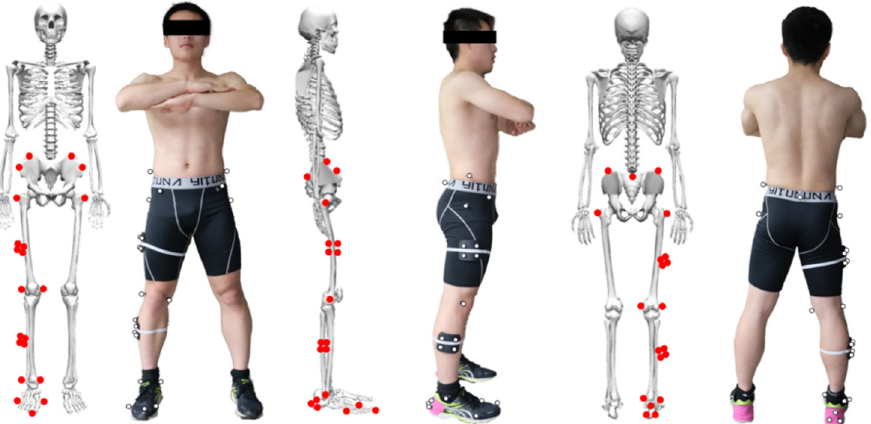
Figure 1. The placement of the reflective markers (front view, side view and back view) following bony anatomical landmarks.